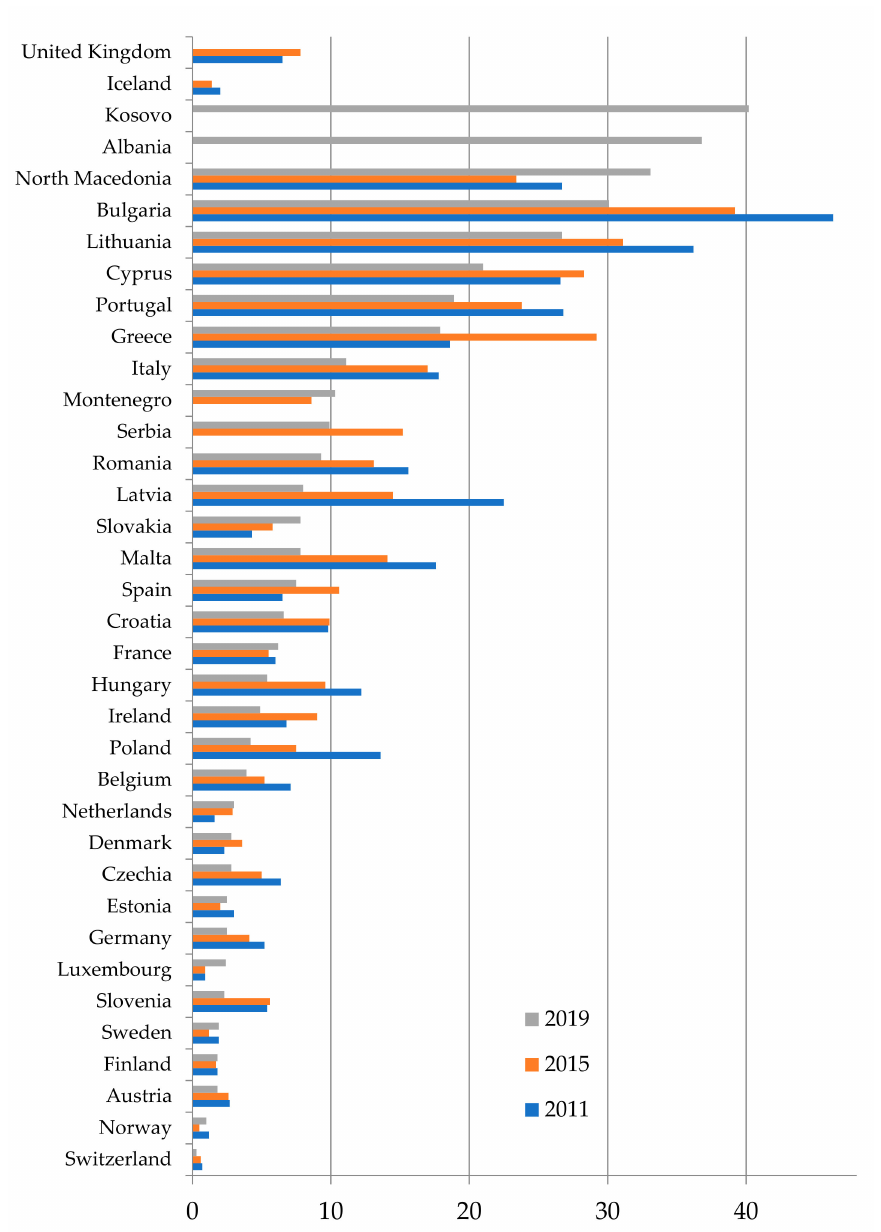
Figure 5. Inability to keep home adequately warm in European countries in 2011, 2015, 2019 %. (2019, Iceland and UK there are no data; 2011, 2015, Kosovo, Albania no data; 2011, Serbia, Montenegro no data). Source: own preparation based on the Eurostat database